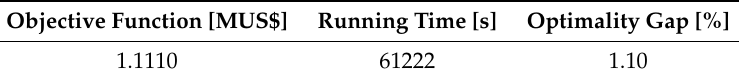
Table 1. Results of Formulation A , server